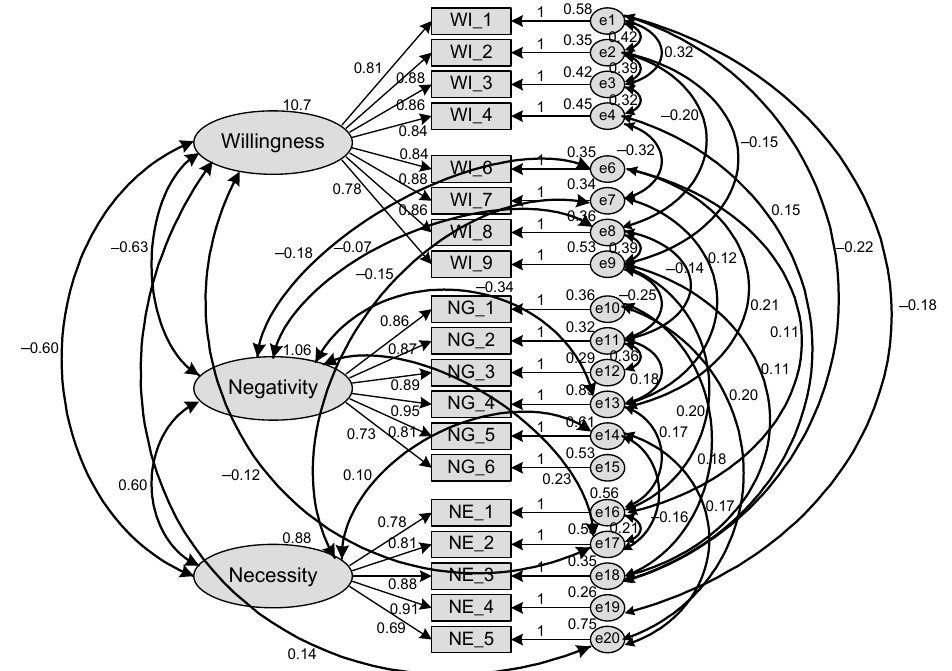
Figure A1. Final confirmatory factor analysis of